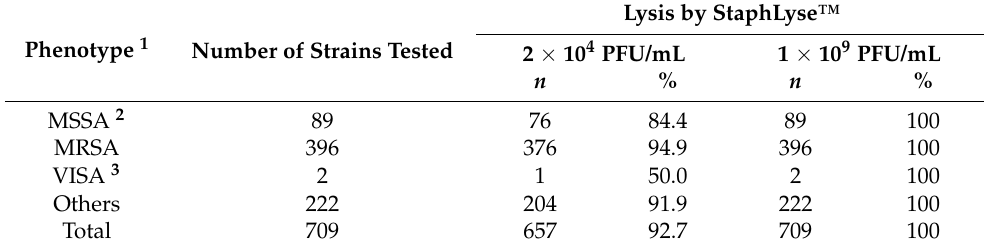
Table 2. Lytic range of StaphLyse™ against S. aureus .